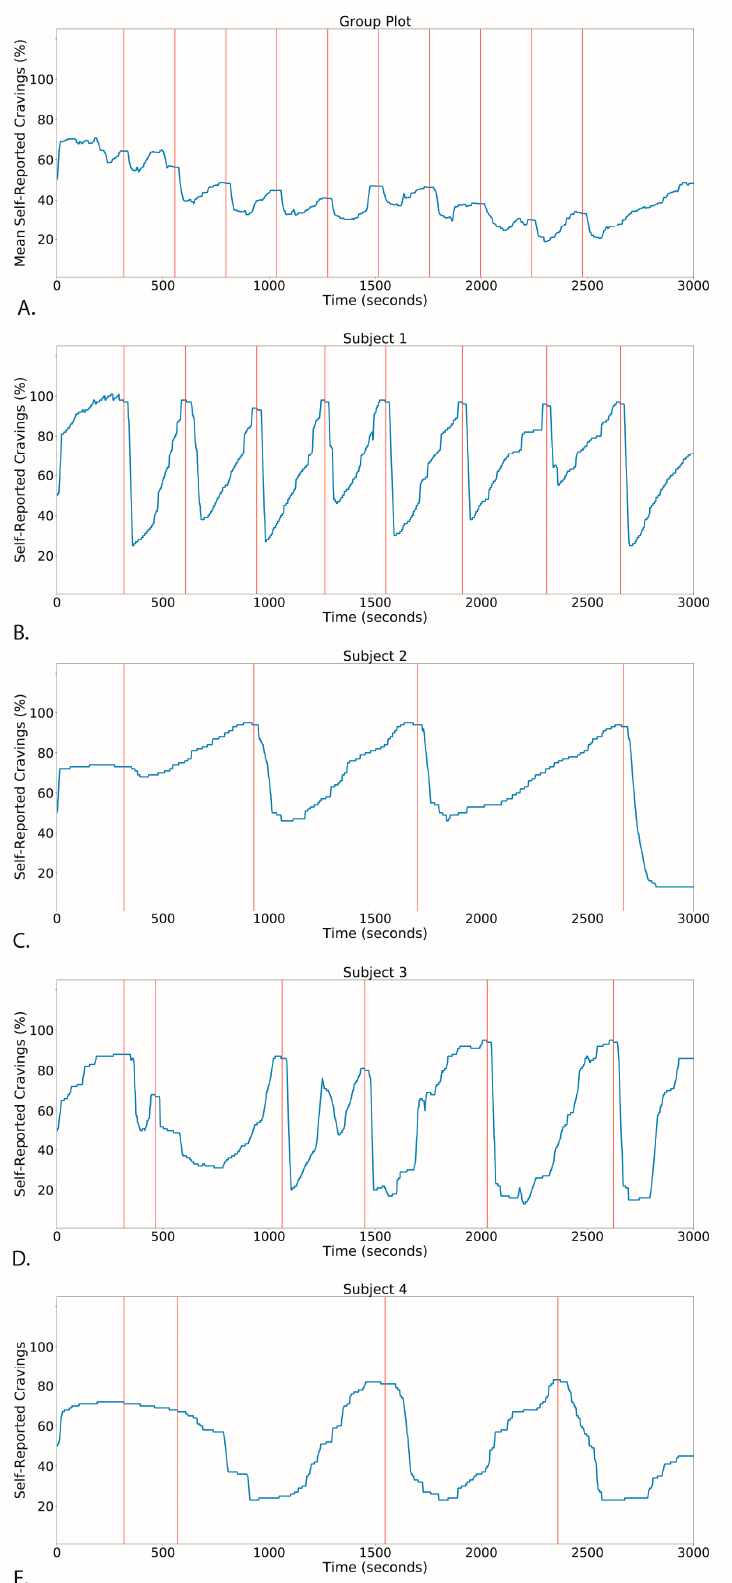
Figure 3. Craving Cycles. Nasal nicotine microdosing elicits craving cycles for fixed inter-trial intervals (4 min) ( A , Craving averaged over all participants in Study C ) and predicts individual dynamics of self ‐ administration ( B – E , Study D ).